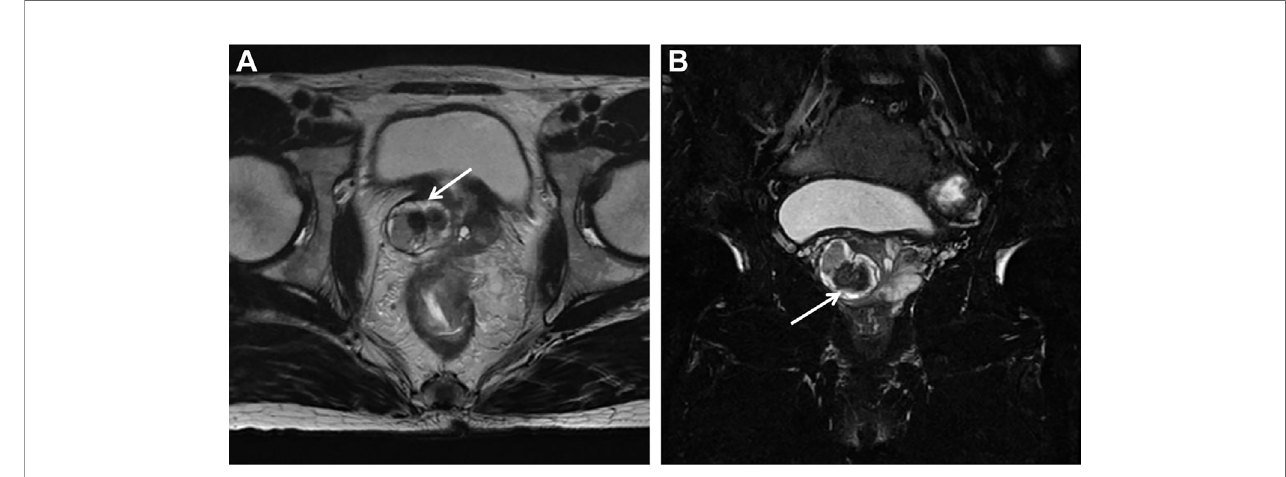
FIGURE 2 | MRI detected a round-like mixed signal lesion in the right lobe of the prostate. T2WI showed mixed signal, with high signal around the periphery and a cluster-like low signal in the center. The lesion boundary was clear, with visible capsule, and the diameter was about 36 mm. The right peripheral zone of the prostate was compressed. (A) Axial T2-weighted Image. (B) Coronal Fat-suppressed T2-weighted